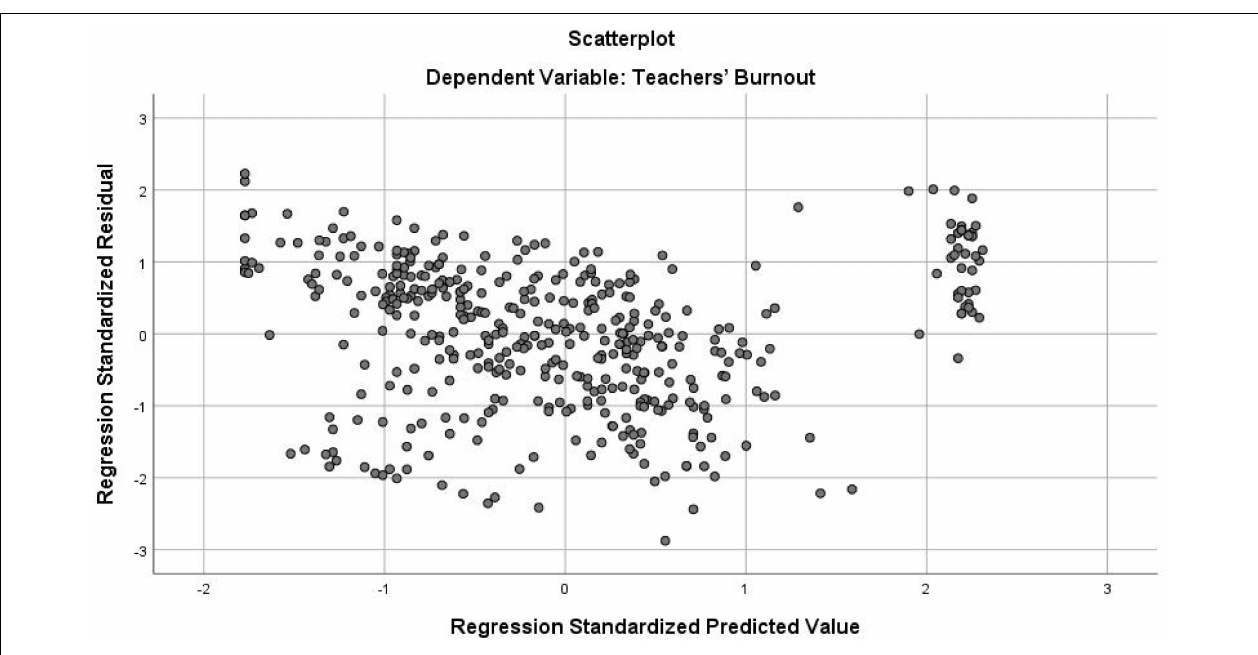
FIGURE 2 | Scatter plot with teachers’ self-efficacy as dependent